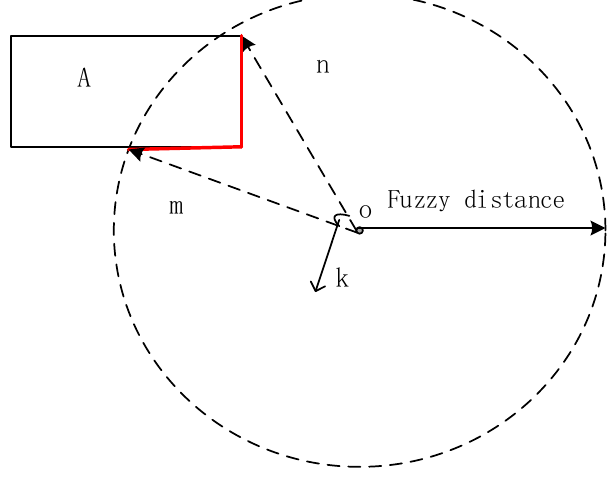
Figure 12. Restrictions of visible segment A; angle K should meet the restriction.